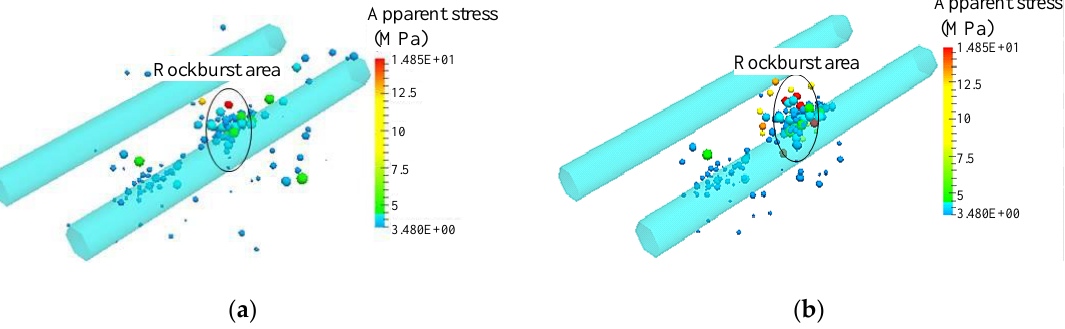
Figure 15. Distribution of microseismic events during rockburst in the Micang Mountain tunnel: ( a ) location based on single-tube array; ( b ) location based on twin-tube array. Spheres represent a microseismic event and their color represents apparent stress.